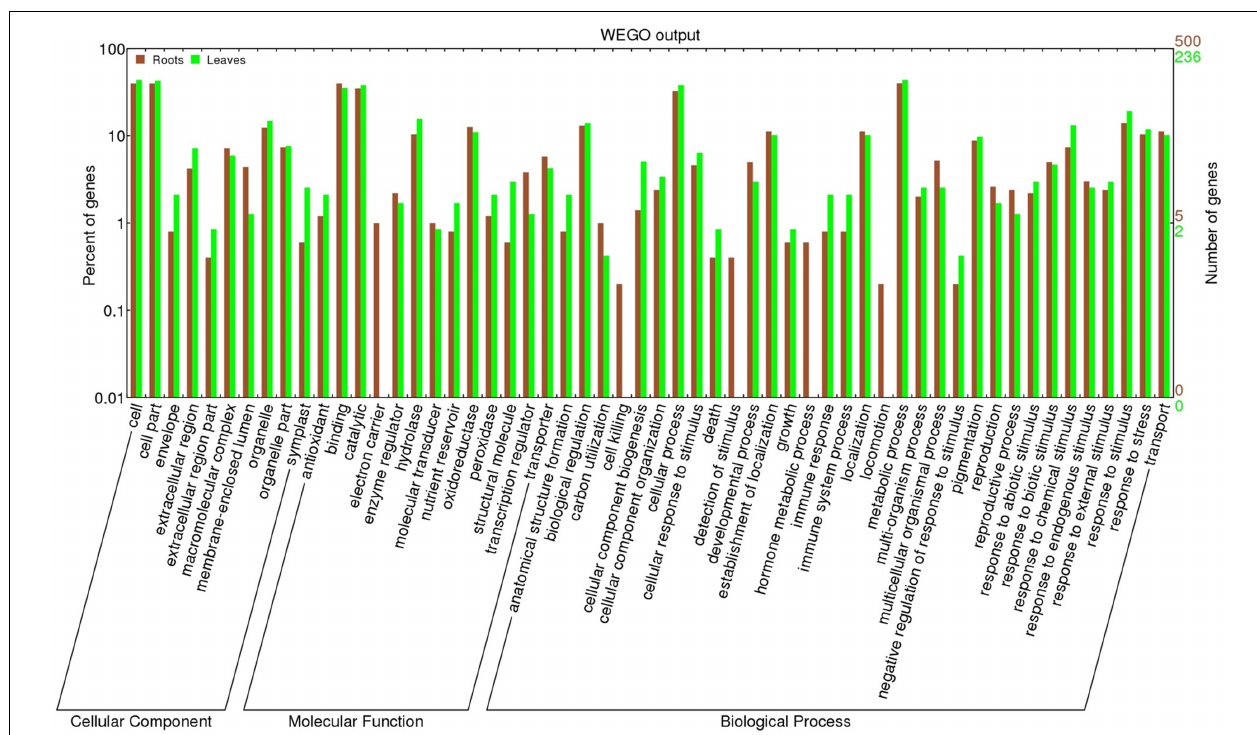
FIGURE 3 | Histogram of GO terms assigned to DEGs in roots (GF677 rootstock, n = 500) and leaves (graft, var. Catherina, n = 236). The DEGs are categorized into three main groups: cellular components (CCs), molecular functions (MFs), and biological processes (BPs). Note that the vertical axes use a logarithmic